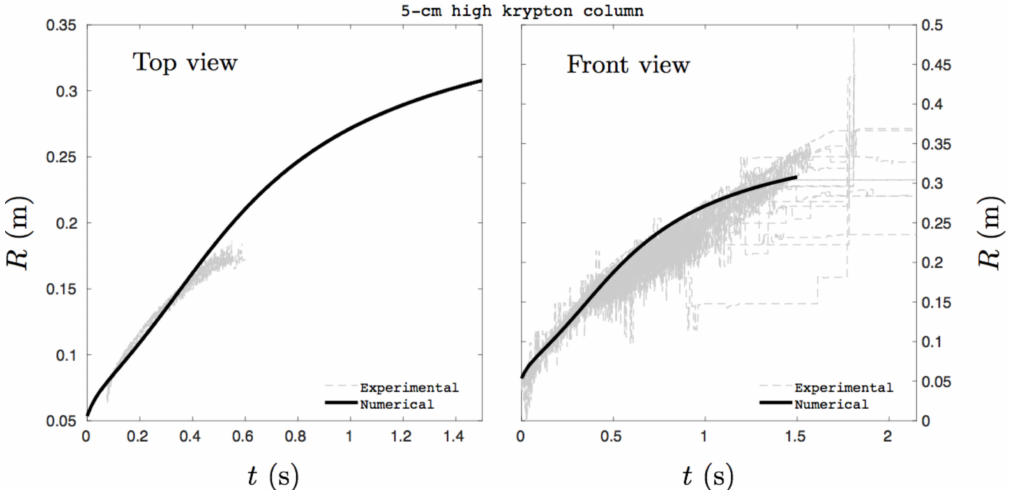
Figure 9. Temporal evolution of the krypton front position. Comparison of the one-dimensional solution of the present two-layer shallow water model versus experimental data. The initial krypton column is 5-cm high. Computed results are in good agreement with experimental measurements.